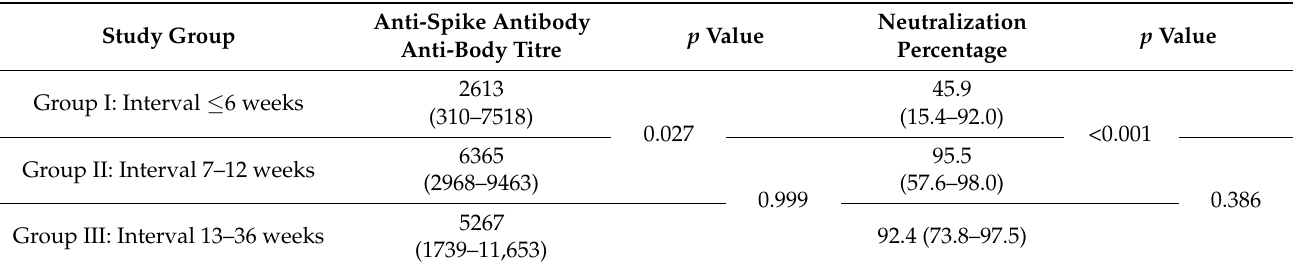
Table 2. Comparison of COVID-19 anti-spike antibody titre and percentage of neutralizing antibody between the groups who were given two doses of vaccine at different intervals.